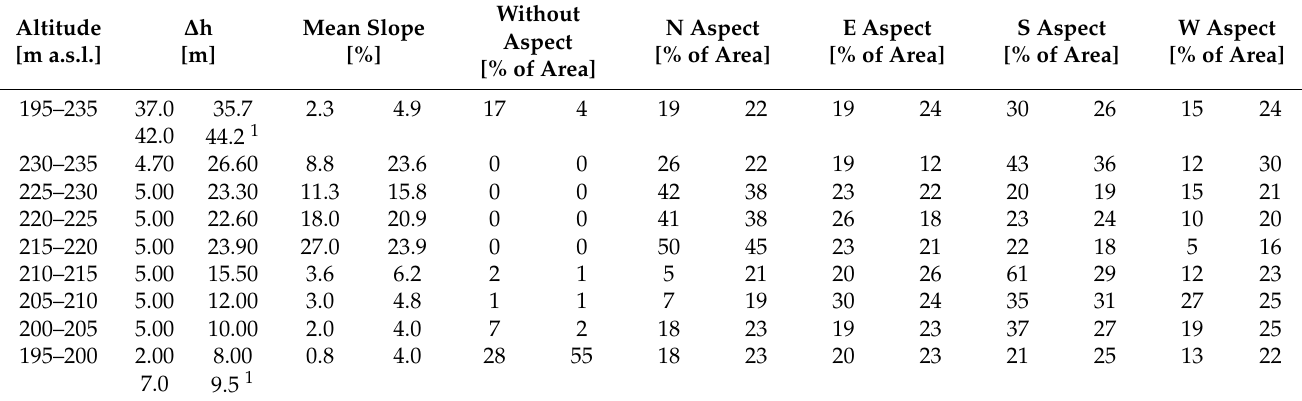
Table 2. Values of topographic parameters: (1)—left and (2)—right, based on the second method. Explanations in the text.